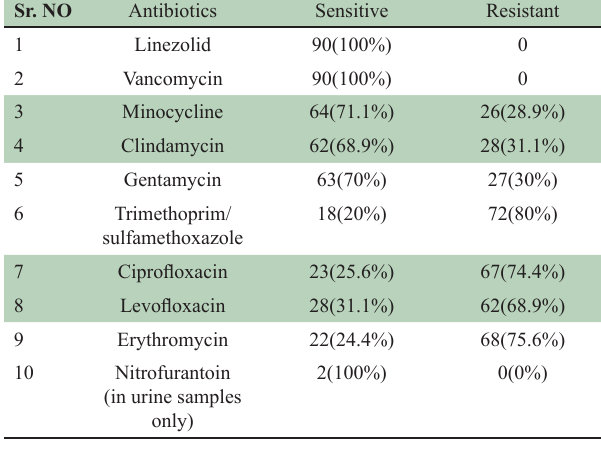
Table-II: Antimicrobial Susceptibility pattern of